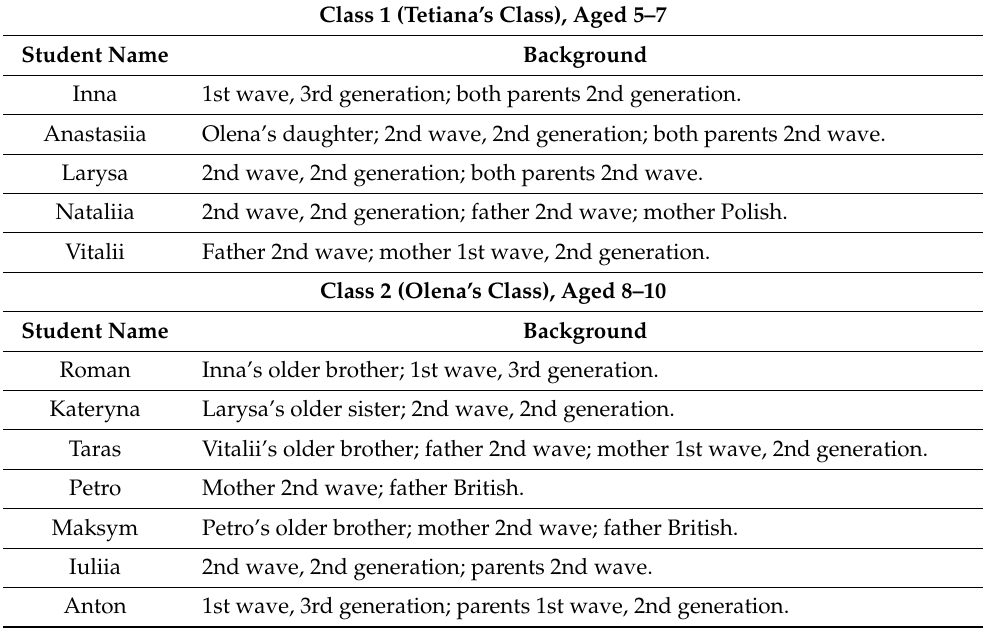
Table 1. Complementary school student